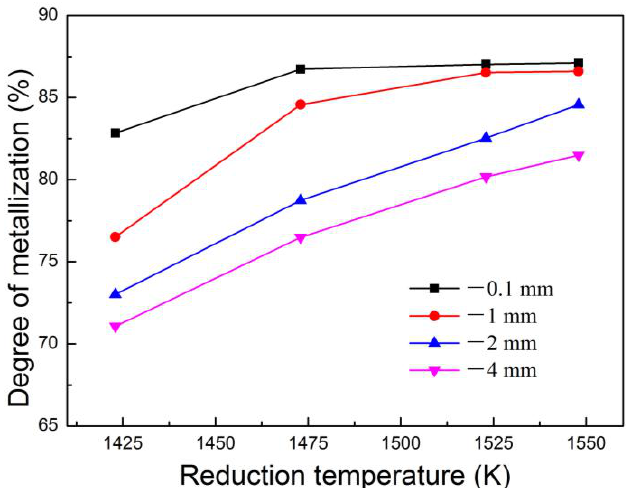
Figure 3. Effects of temperature on the degree of metallization of reduced briquettes at different ore size fractions.